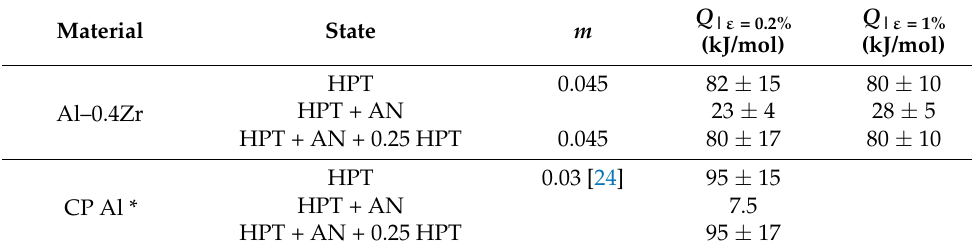
Figure 8. The natural logarithm of the flow stress at ε = 1% as a function of the inverse temperature for the Al–0.4Zr alloy in three different states. Table 3. Strain-rate sensitivity coefficient ( m ) and the activation energy ( Q).